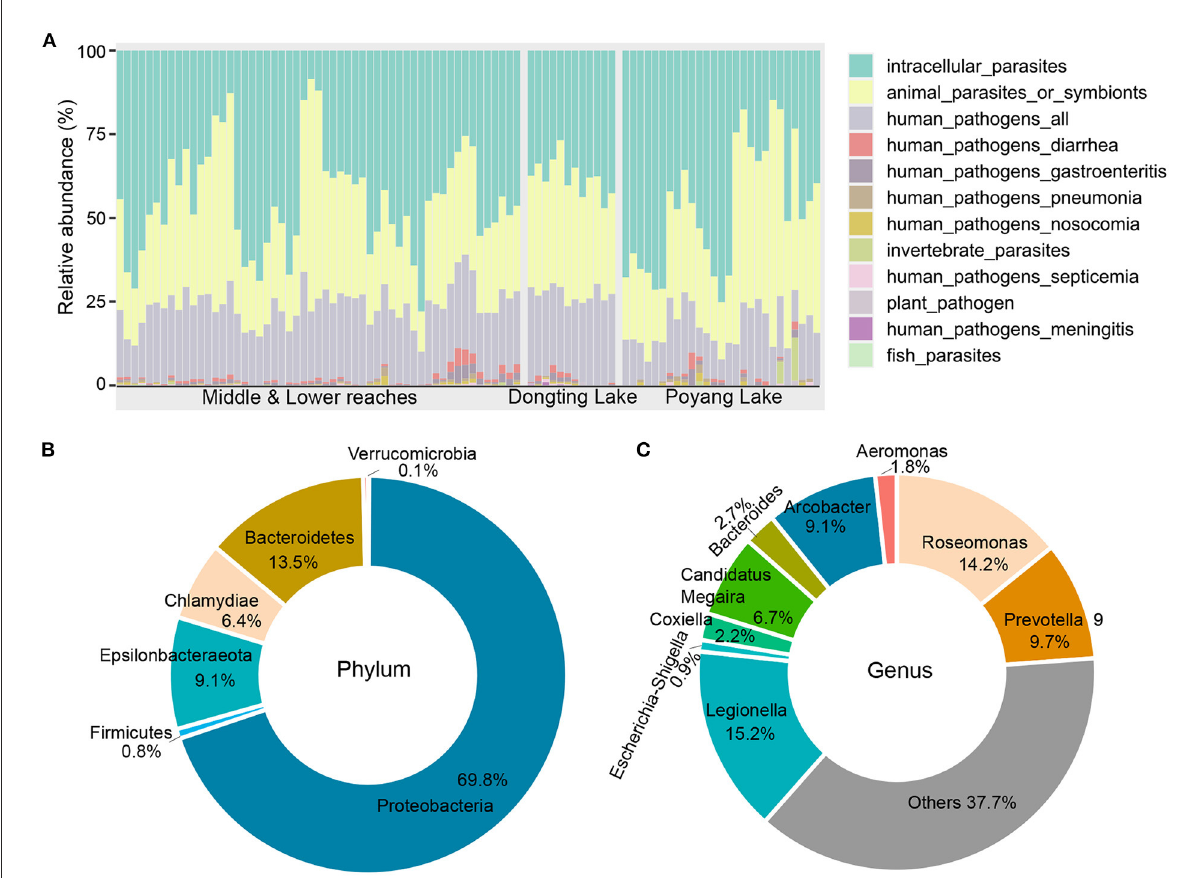
FIGURE2 Functional and taxonomic composition of the potential pathogenic bacteria identified in this study. (A) Functional composition across all samples. (B) Taxonomic composition at the phylum level. (C) Taxonomic composition at the genus